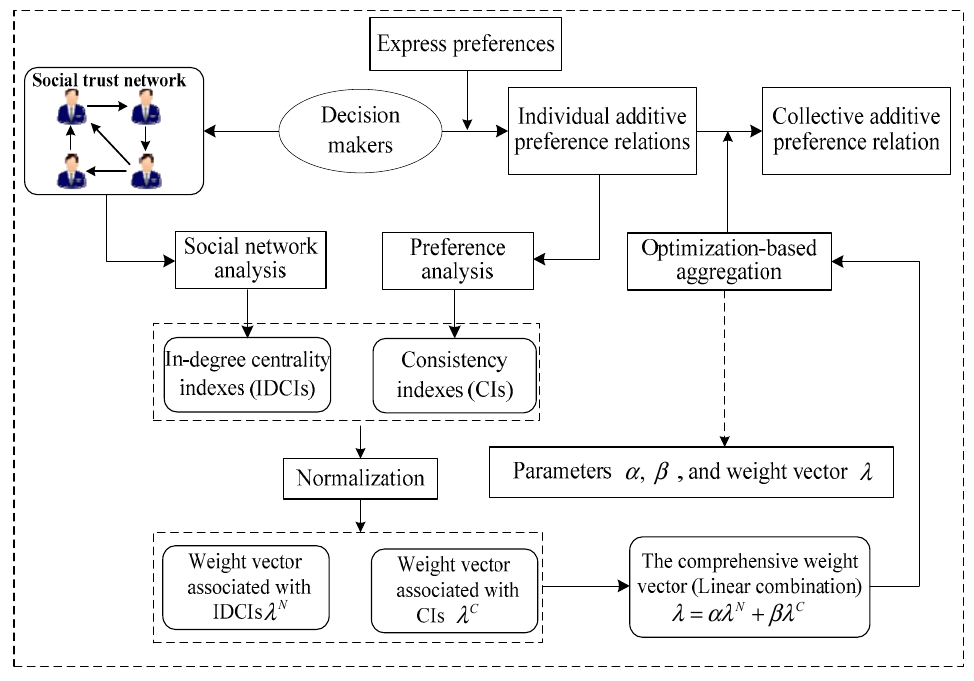
Figure 1. The optimization-based social network group decision making (SNGDM) framework.